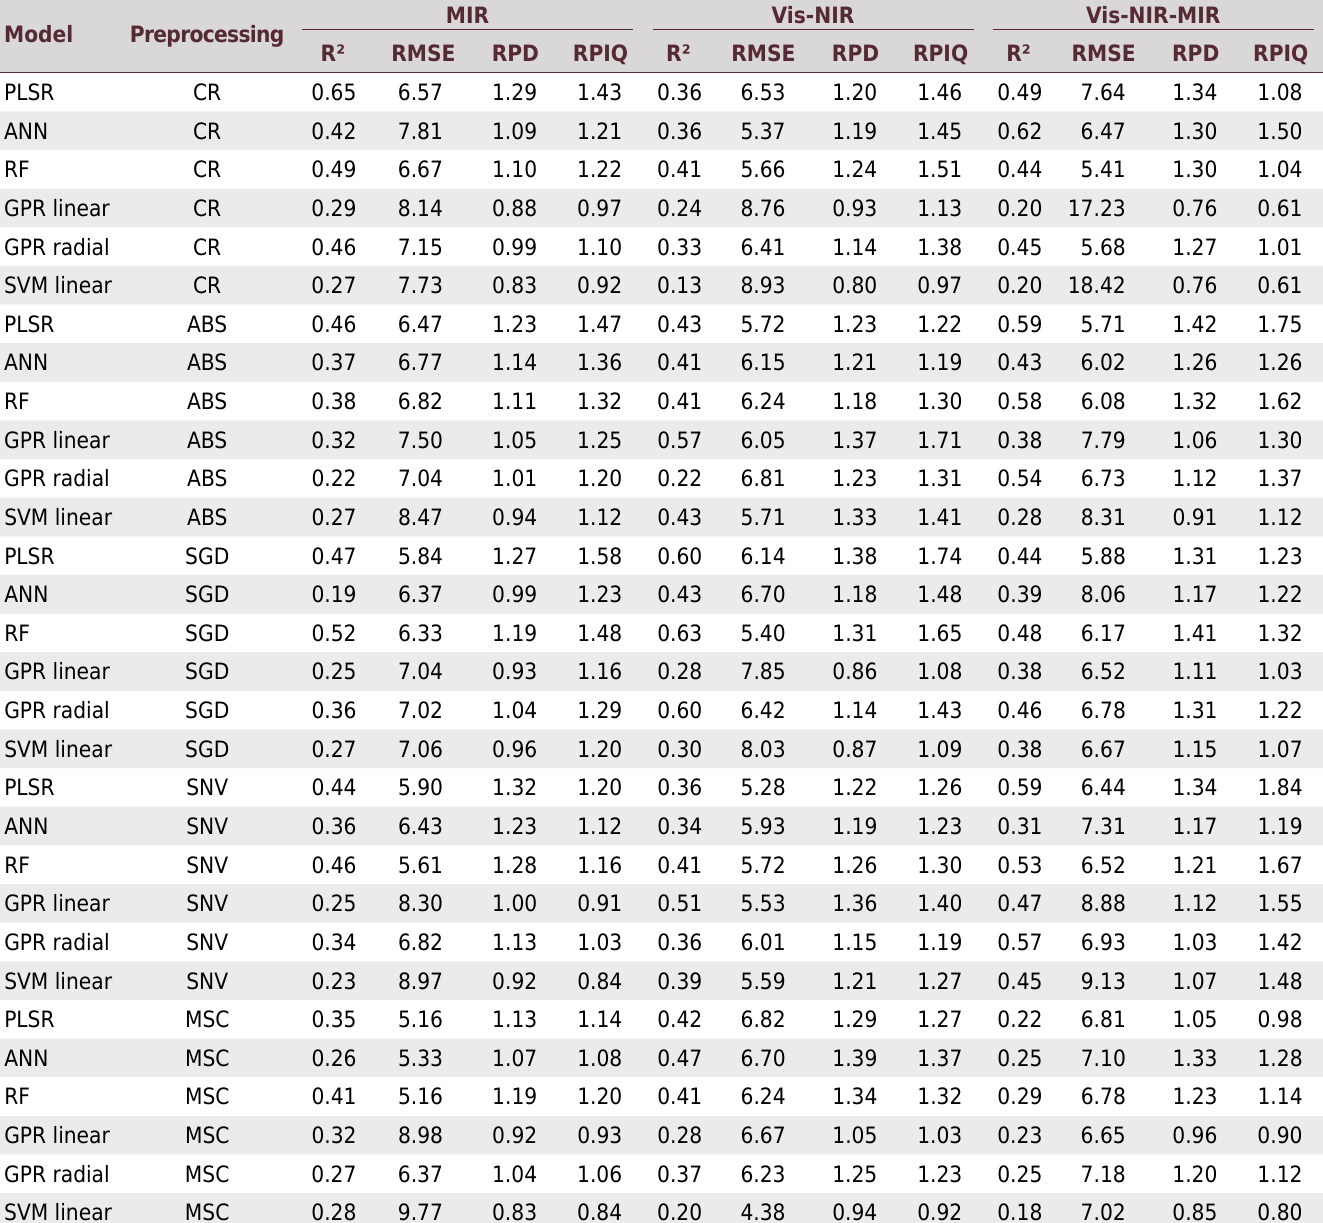
Table 3. The values of R 2 , RMSE, RPD, and RPIQ for the organic carbon property found for the different models and preprocessing methods in the MIR, Vis-NIR, and Vis-NIR-MIR Model Preprocessing